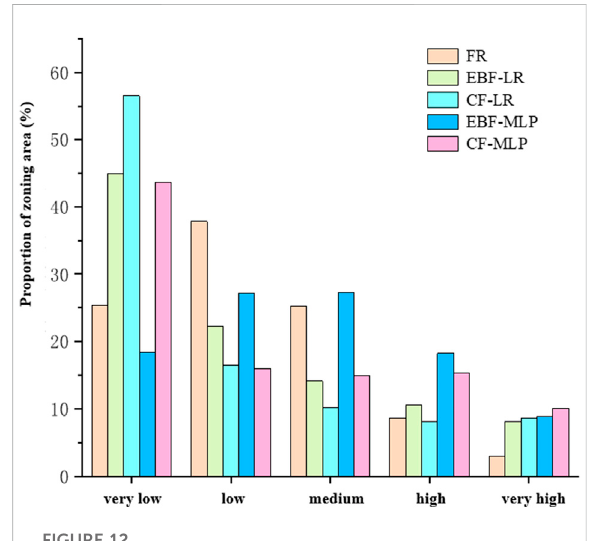
FIGURE 12 Histogram of area proportion of susceptibility grade zoning.